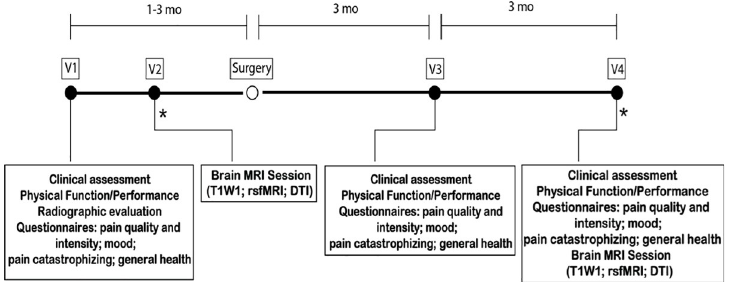
Fig 1. Experimental design, timeline and data collected. Knee and hip osteoarthritis patients entered a 4 visit (V1-V4), pre- and post-total joint replacement surgery, longitudinal, observational study. V1 and V2 occurred before surgery. V3 and V4 took place at 3 and 6 months after surgery. At each visit, participants underwent a series of assessments. � Brain MRI session. mo, months; MRI, magnetic resonance imaging; T1WI, T1-weighted imaging; rsfMRI, resting state functional magnetic resonance imaging; DTI, diffusion tensor